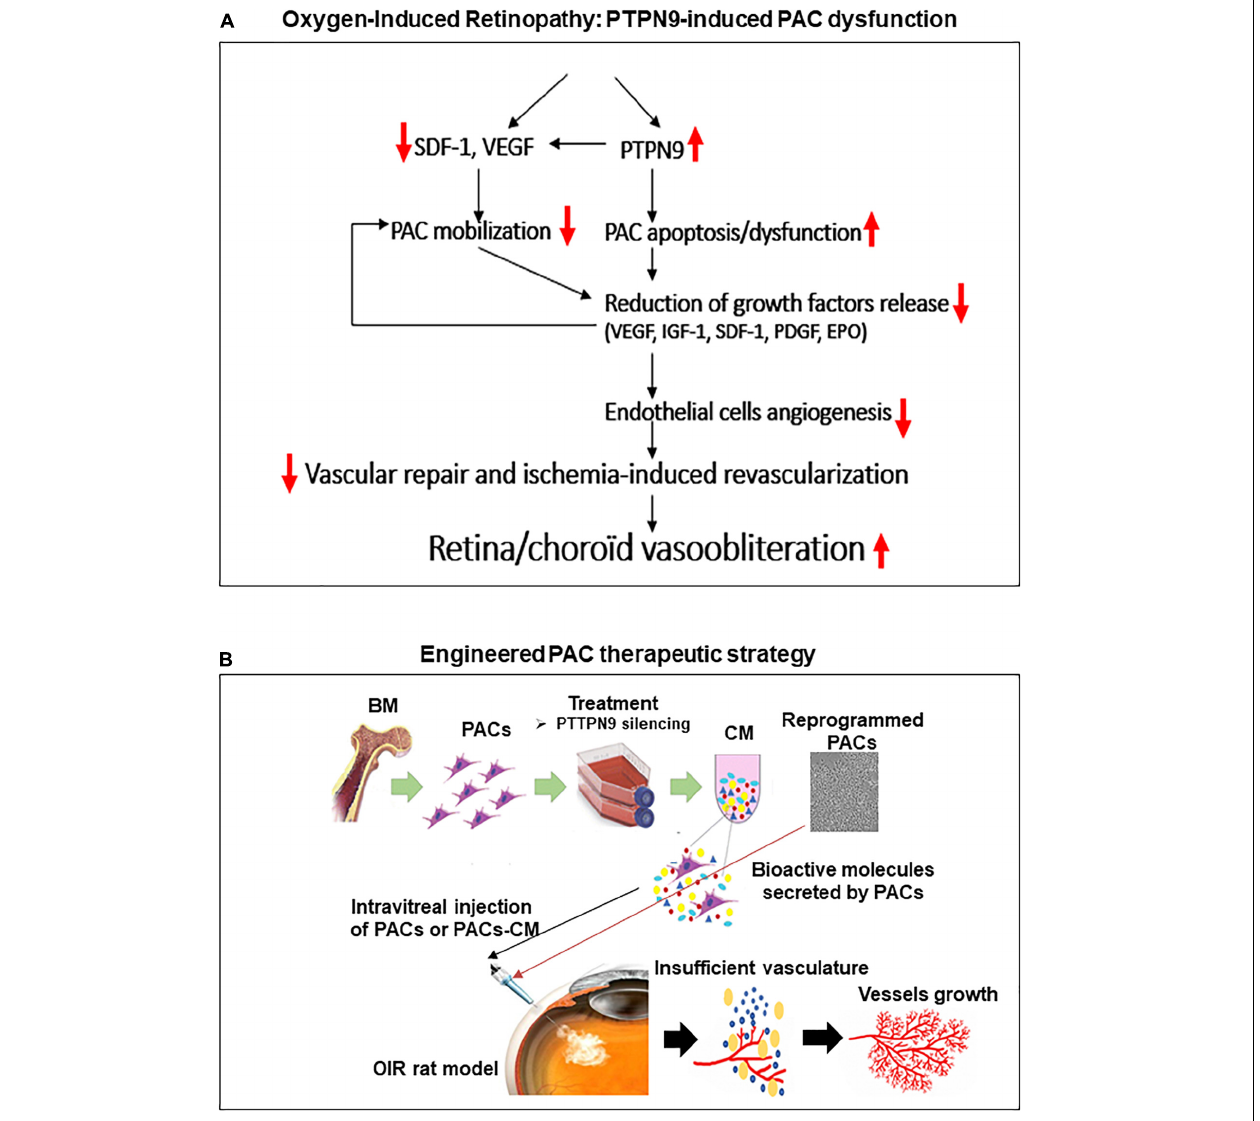
FIGURE 7 | Schematic summary of the study. Proposed mechanisms for the negative regulation of PAC function by PTPN9 during OIR (A) , and vaso-protective potential of PAC-based therapy to improve retinal neovascularization (B)